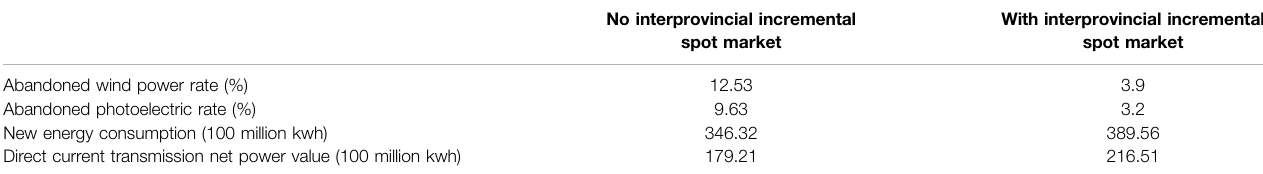
TABLE 1 | Comparison of new energy consumption in the Gansu province before and after the interprovincial incremental spot market mode.